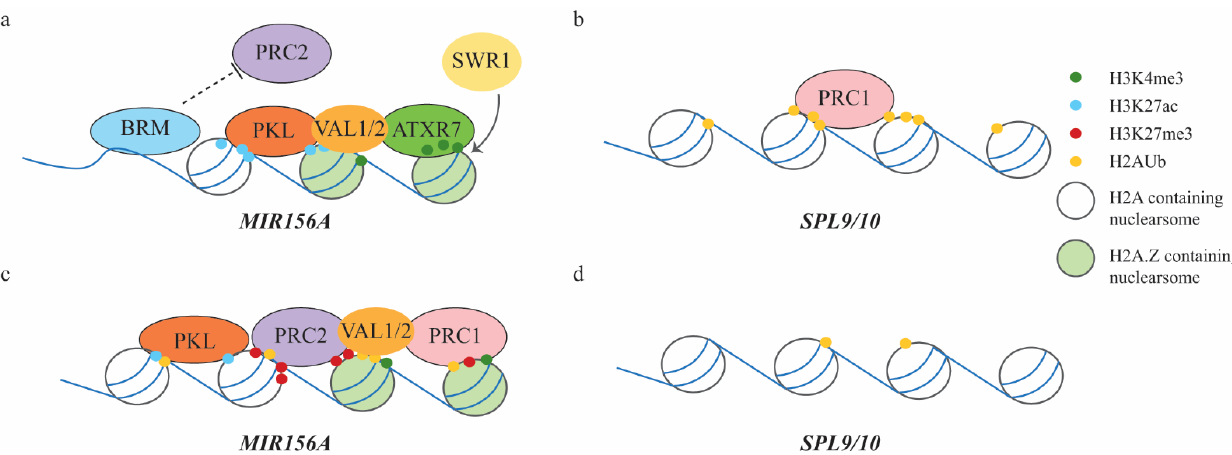
Figure 3. Model of PRC1 and PRC2 action during juvenile-to-adult vegetative phase change. ( a , b ) PRC1 and PRC2 during juvenile phase. ( a ) BRM prevents the formation of nucleosomes near the transition start site (TSS) of MIR156A and possibly prevents binding of PRC2 to MIR156A . PKL binds to MIR156A during juvenile phase and is associated with modulating H3K27ac levels. SWR1 mediates the exchange of H2A to H2A.Z, which works in concert with ATXR7 to deposit H3K4me3. ( b ) SPL9 and SPL10 are marked by H2Aub that deposited by PRC1 to prevent precocious vegetative phase change. ( c , d ) PRC1 and PRC2 during adult phase. ( c ) PKL facilitates nucleosome formation near the TSS and PRC1 and PRC2 are recruited to MIR156A to increase the abundance of H3K27me3 and H2AUb, while the abundance of H3K27ac and H3K4me3 are decreased. VAL1/2 bind to MIR156A to recruit PRC1 and PRC2. ( d ) PRC1 leaves SPL9/10 to allow for their activation.